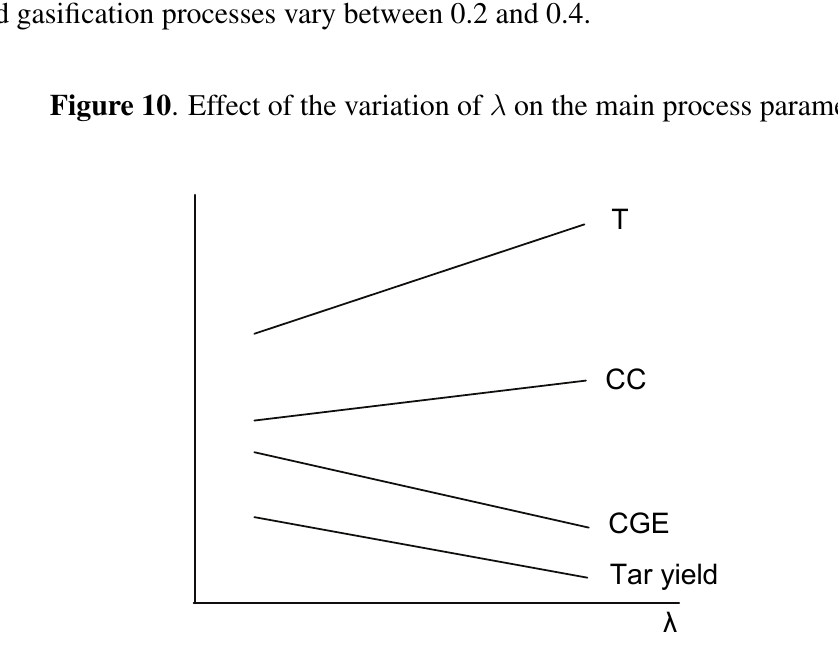
Figure 10 . Effect of the variation of (cid:21) on the main process parameters.